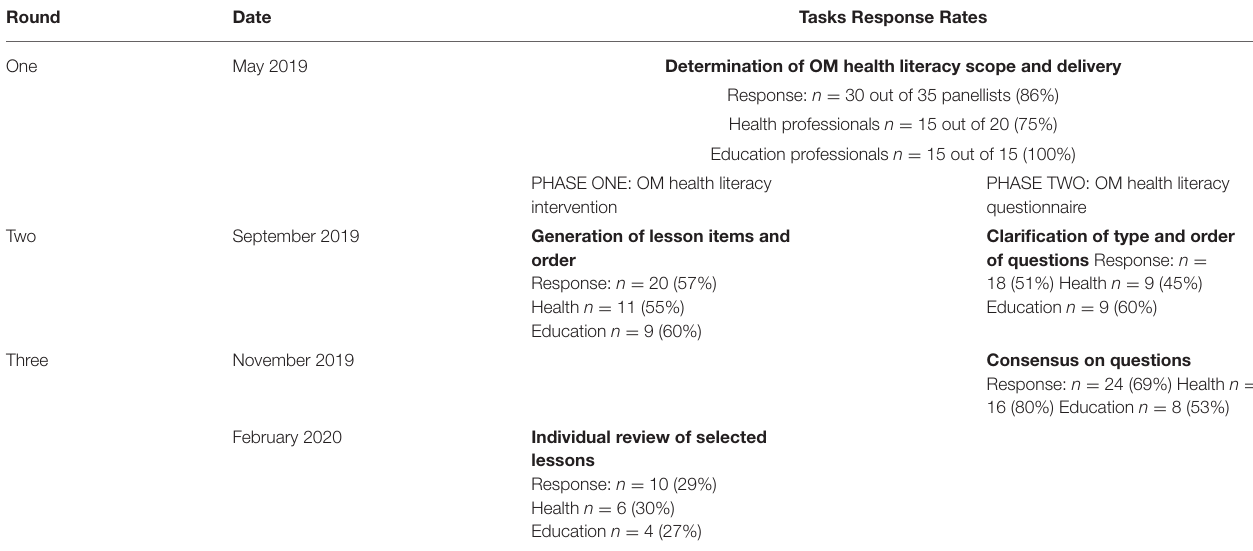
TABLE 1 | Delphi Panel design, timeline and response